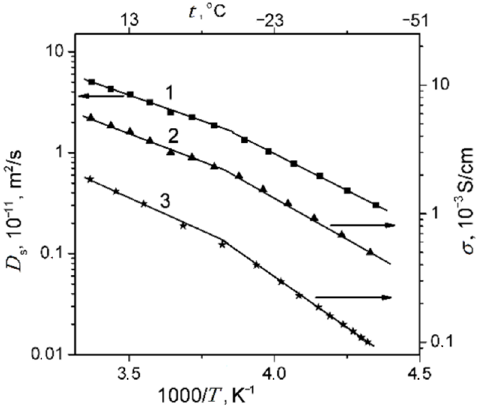
Figure 31. Temperature dependences of the self-diffusion coefficients (curve 1) and proton conductivity calculated from Equation (7) (curve 2), λ = 4.4. Curve 3: experimental temperature dependence of the conductivity for λ = 3.7. Adapted from [25,106].